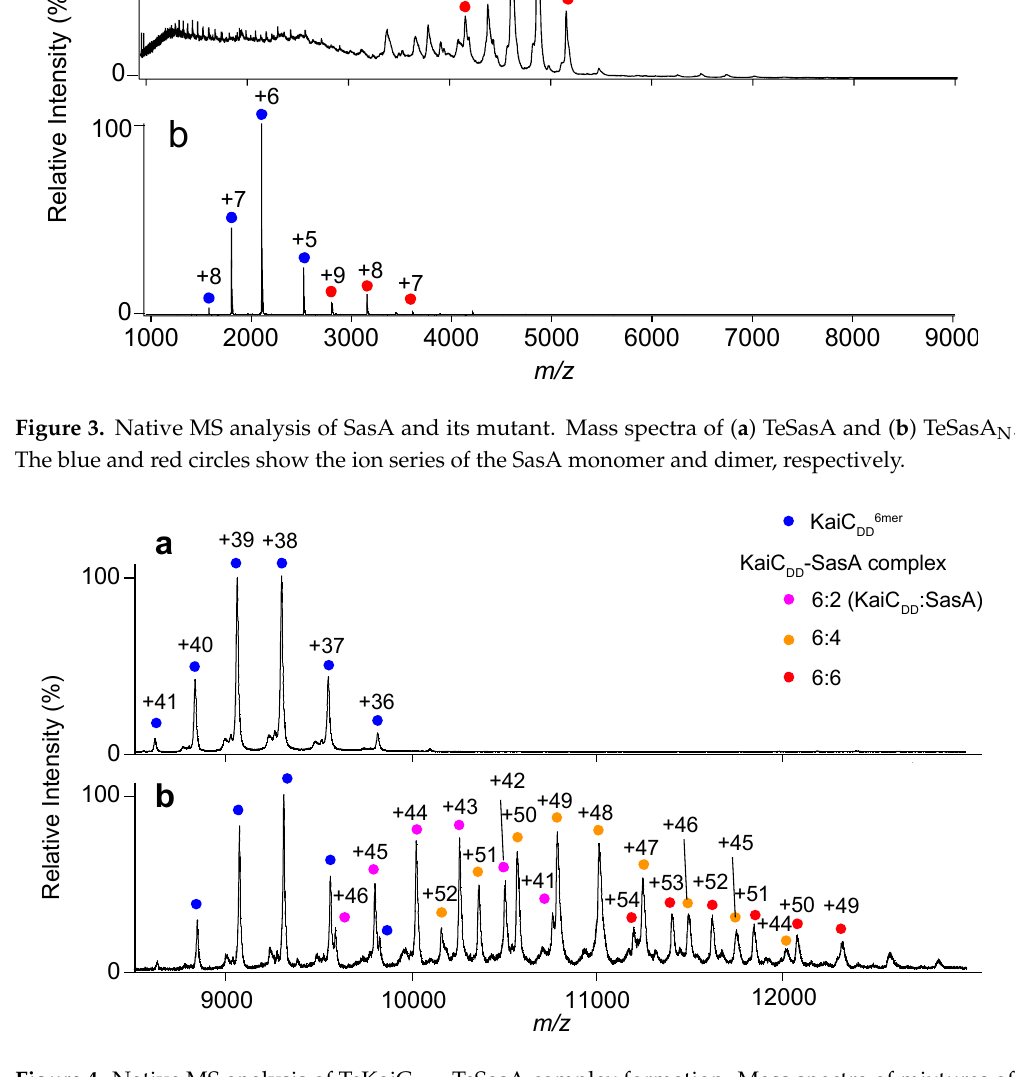
Figure 4. Native MS analysis of TeKaiC DD –TeSasA complex formation. Mass spectra of mixtures of TeKaiC DD and TeSasA at ( a ) 1:0 and ( b ) 1:1 molar ratios (TeKaiC DD to TeSasA). The blue, magenta, orange, and red circles show the ion series of the TeKaiC DD homohexamer and 6:2, 6:4, and 6:6 complexes of TeKaiC DD and TeSasA, respectively.